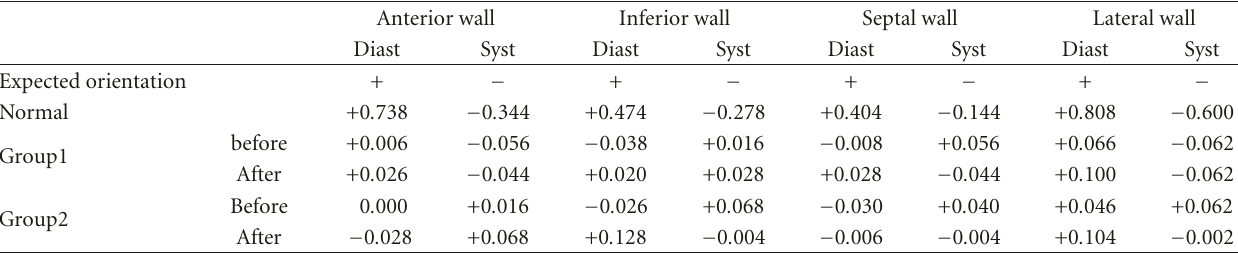
Table 1: Mean intensity values for radial motion of one normal subject and two patients, one of Group1 and one of Group2, before and after CRT. Values presented for the walls depicted in Figure 1—anterior, inferior, septal, and lateral—for the LV midcavity portion. The computed intensity values are mapped to a scale that allows a maximum of +1 and a correspondent minimum of − 1. Anterior wall Inferior wall Septal wall Lateral wall Diast Syst Diast Syst Diast Syst Diast